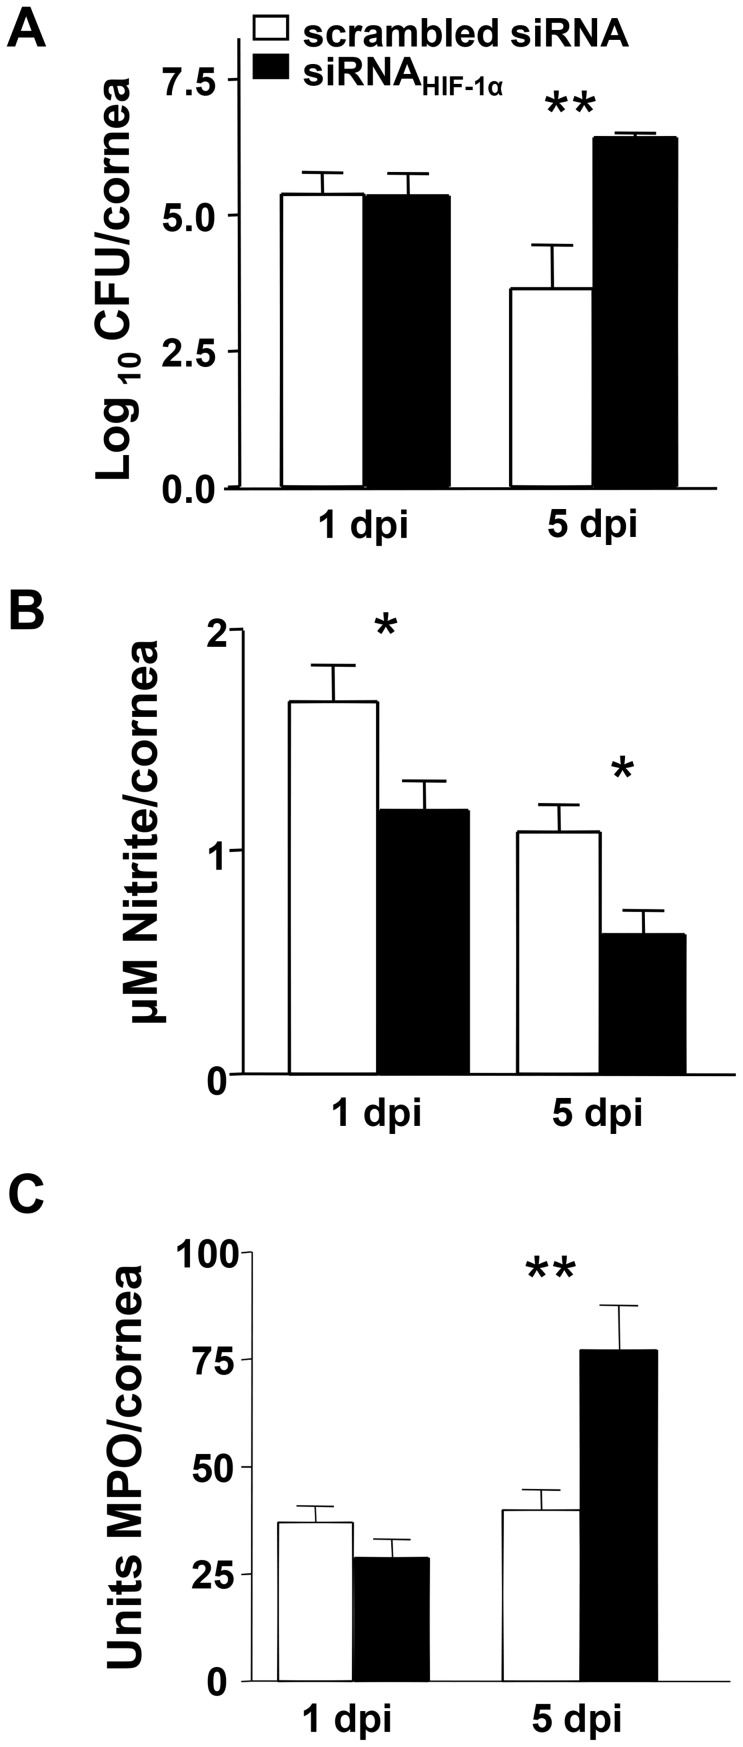
In vivo effects of siRNAHIF-1α treatment.Bacterial counts (A) were detected from corneas of scrambled siRNA- and siRNAHIF-1α-treated mice after P. aeruginosa ocular infection. Results showed statistically more bacteria after HIF-1α silencing at 5 days p.i. Nitrite levels (B) were significantly reduced at both 1 and 5 days p.i. after siRNAHIF-1α treatment when compared to scrambled controls. Corneal levels of MPO (C) were significantly increased at 5 days p.i. in siRNAHIF-1α versus scrambled siRNA mice. Data represent three individual experiments each with five mice per group per time point. *P<0.05, ** P<0.01.